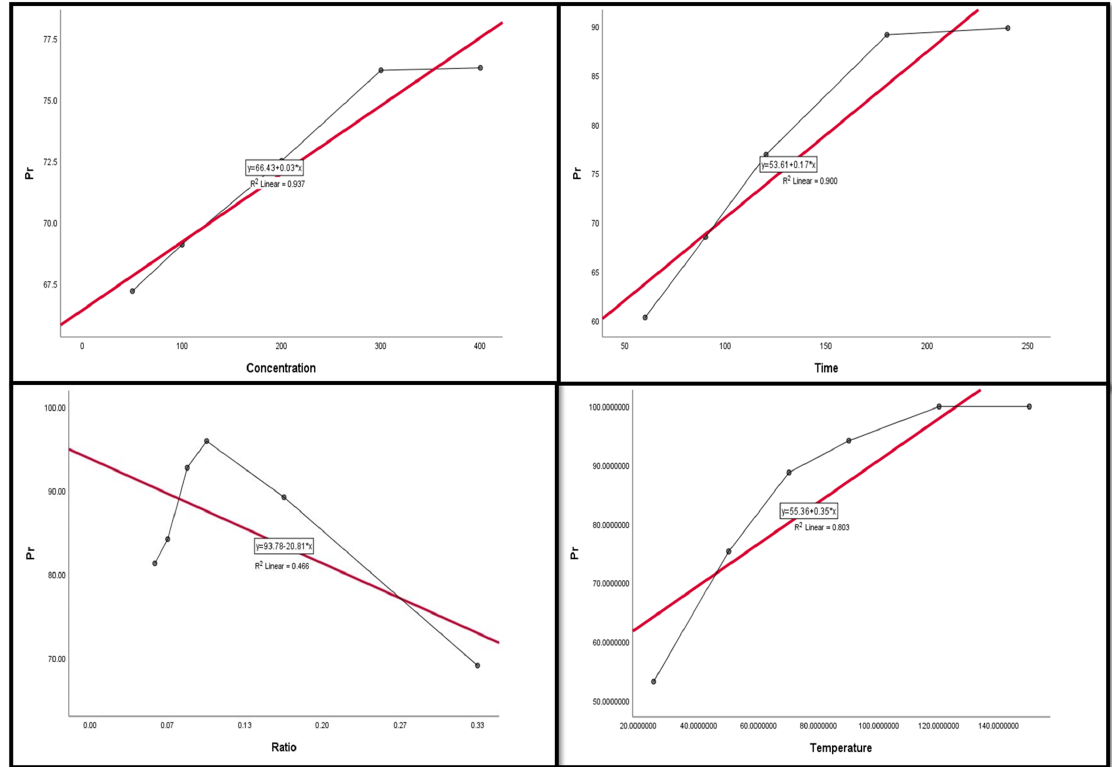
Figure 12. The scatter plot with linear regression fit for Pr leaching efficiency, %, and factors.